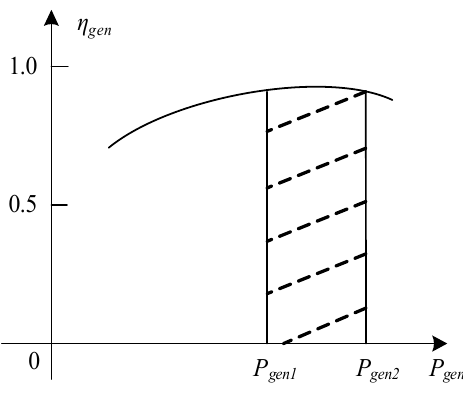
Figure 3. Operation area of the generator.